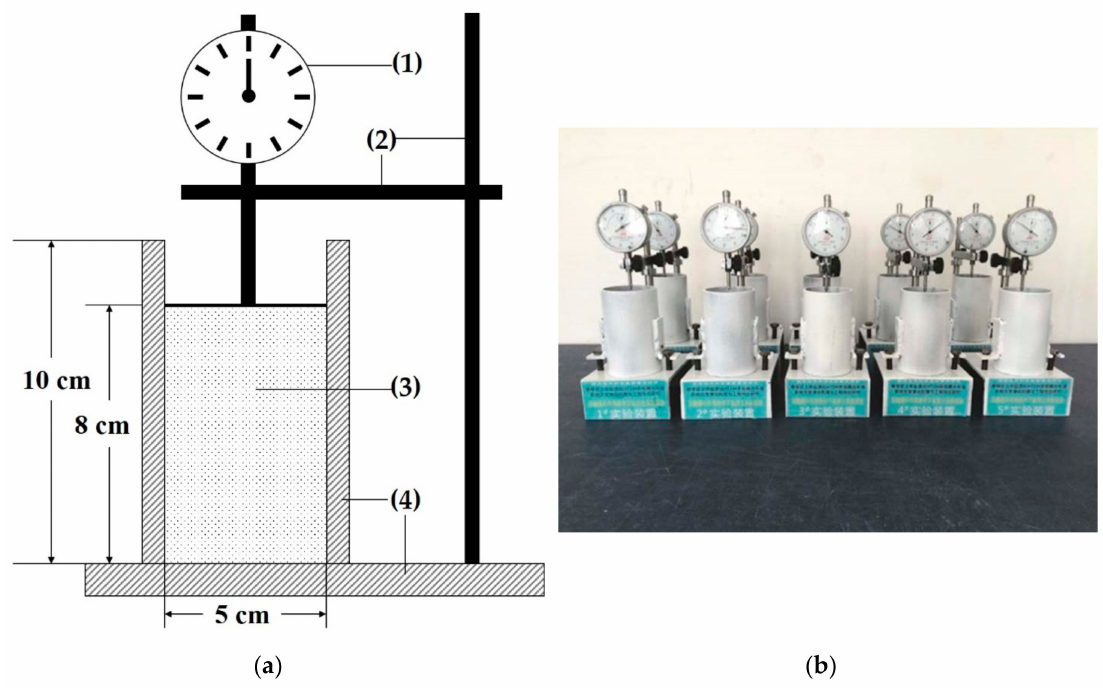
Figure 3. Frost heave experimental setup: ( a ) schematic showing (1) dial indicator, (2) bracket, (3) soil column, (4) tube and pedestal, and ( b ) actual apparatus.